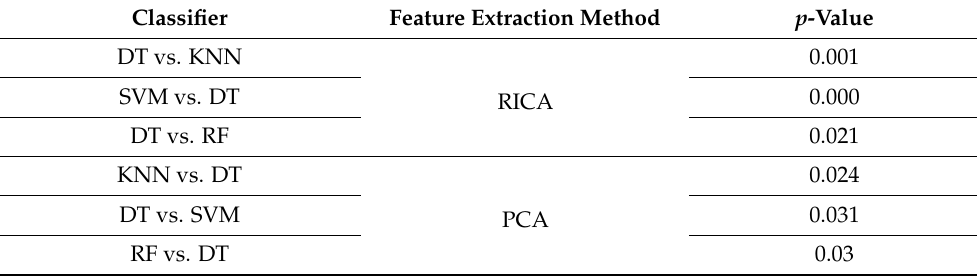
Table 6. p -values for DT, SVM, KNN and RF using the RICA- and PCA-based feature extraction